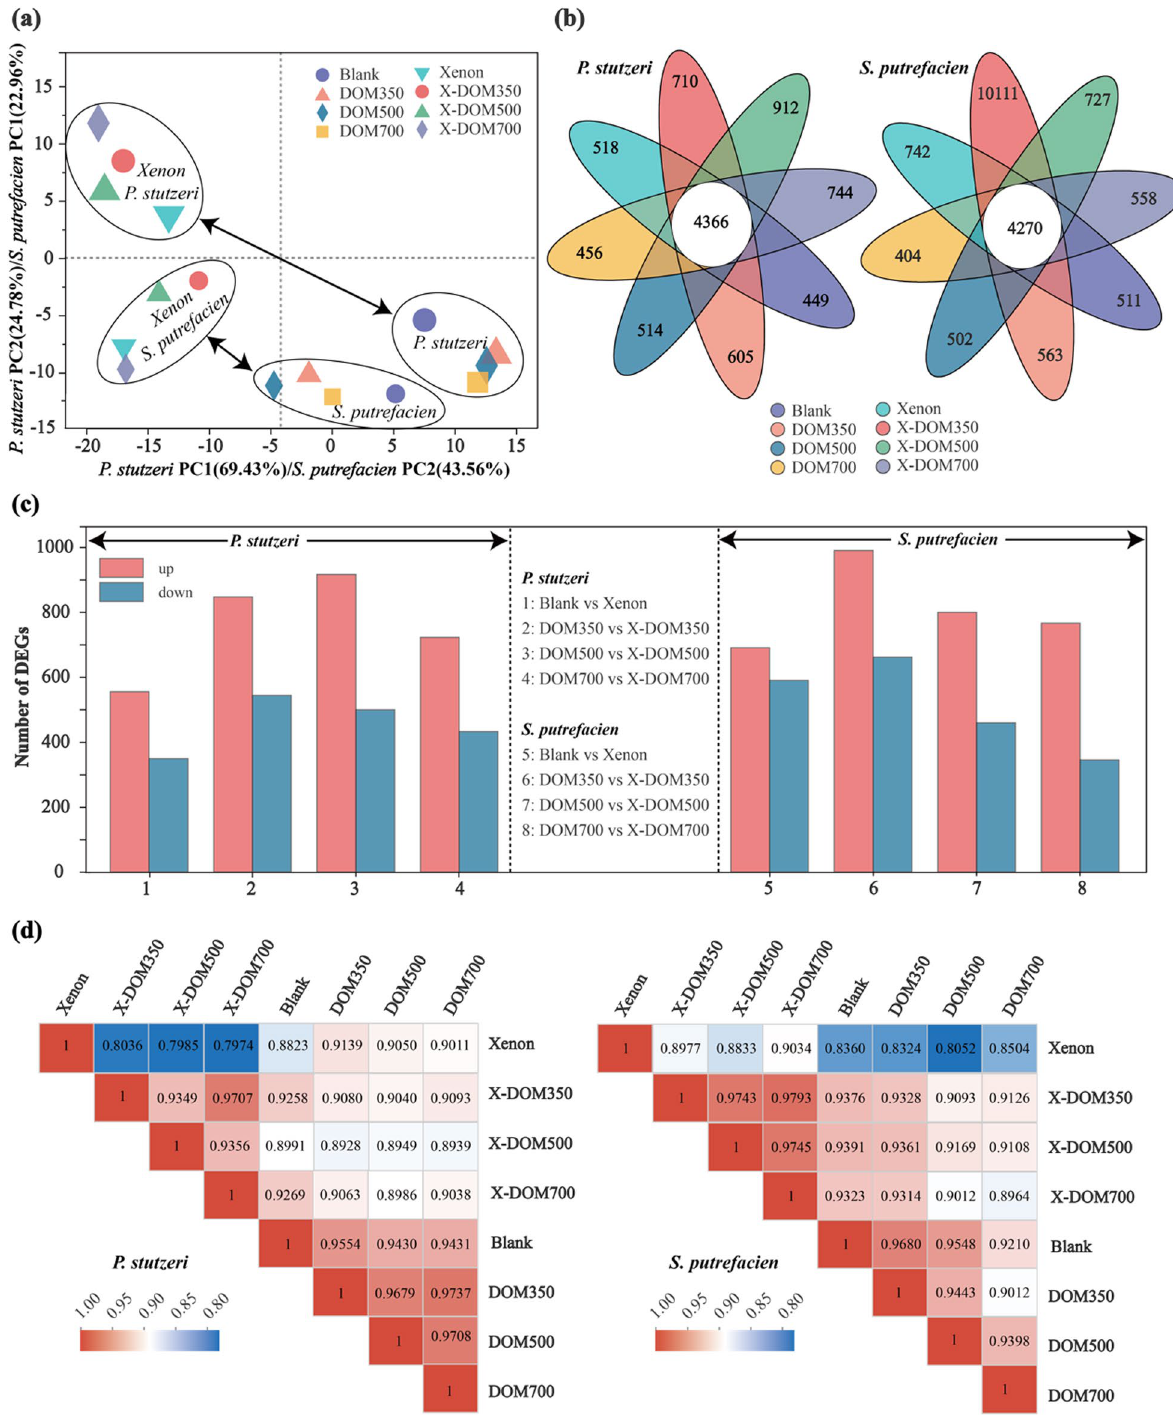
Fig. 4 PCA ( a ) and Venn ( b ) analysis between the DEG of P. stutzeri and S. putrefaciens exposed to xenon lamp irradiation and avoiding light conditions and the detailed number of DEG ( c ). Correlation analysis between the DEG of P. stutzeri and S. putrefaciens exposed to xenon lamp irradiation and avoiding light conditions cultured with different BDOM ( d